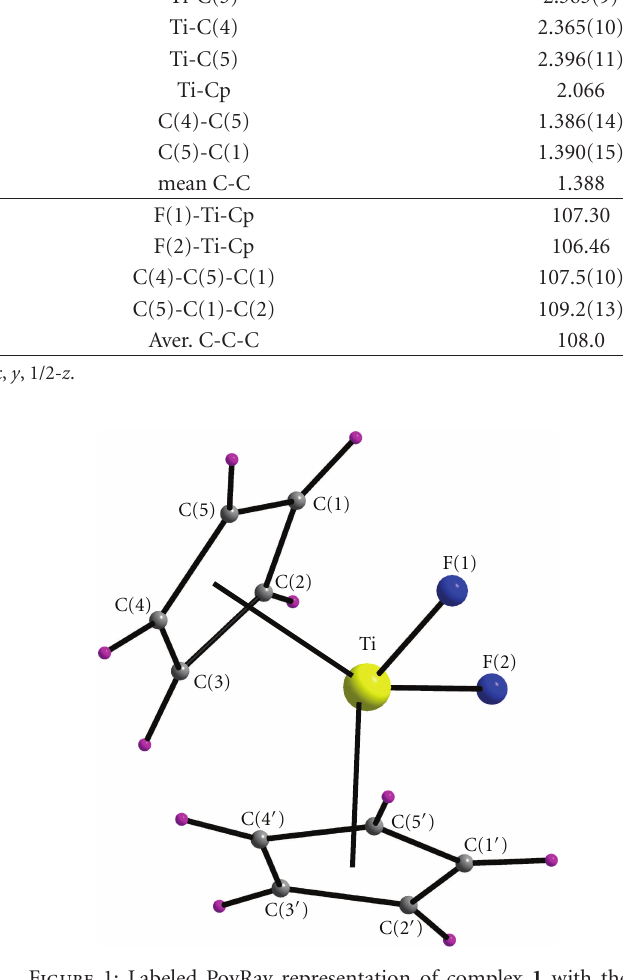
[30] and involves the 1 : 2 reaction of [Ti( η 5 -C 5 H 5 ) 2 Cl 2 ] and the good fluorinating agent { 2-[(CH 3 ) 2 NCH 2 ]C 6 H 4 } (n- Bu) 2 SnF in CH 2 Cl 2